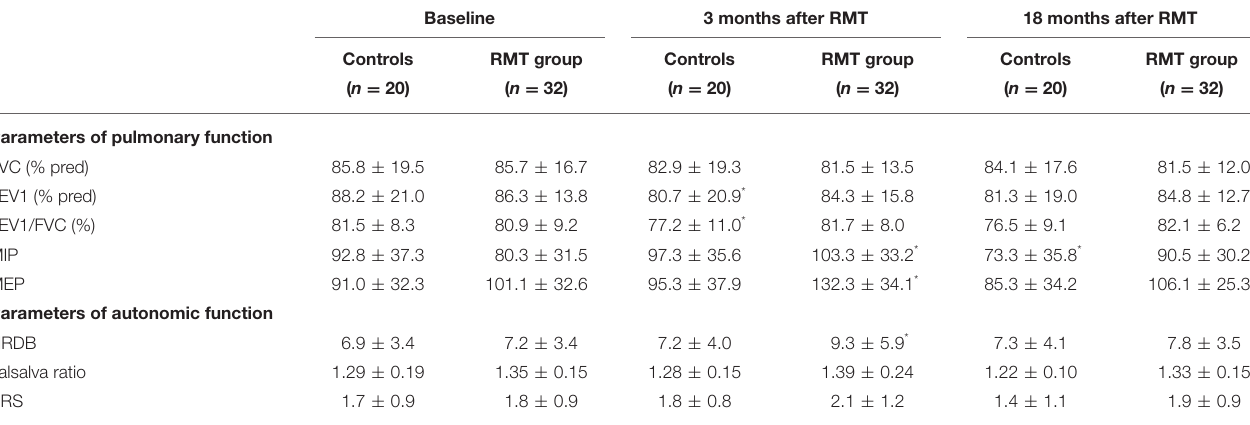
TABLE 2 | Comparison of serial changes of parameters in pulmonary function and autonomic function between two groups. Baseline 3 months after RMT 18 months after RMT Controls RMT group Controls RMT group Controls RMT group ( n = 20) Parameters of pulmonary